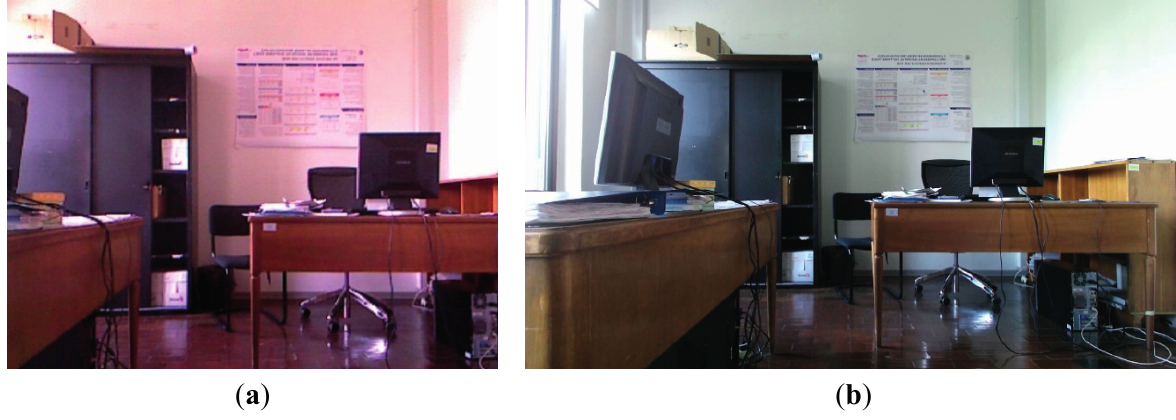
Figure 1. Kinect 1.0 RGB image ( a ) compared with Kinect 2.0 RGB image; ( b ) The two images have been acquired from the same